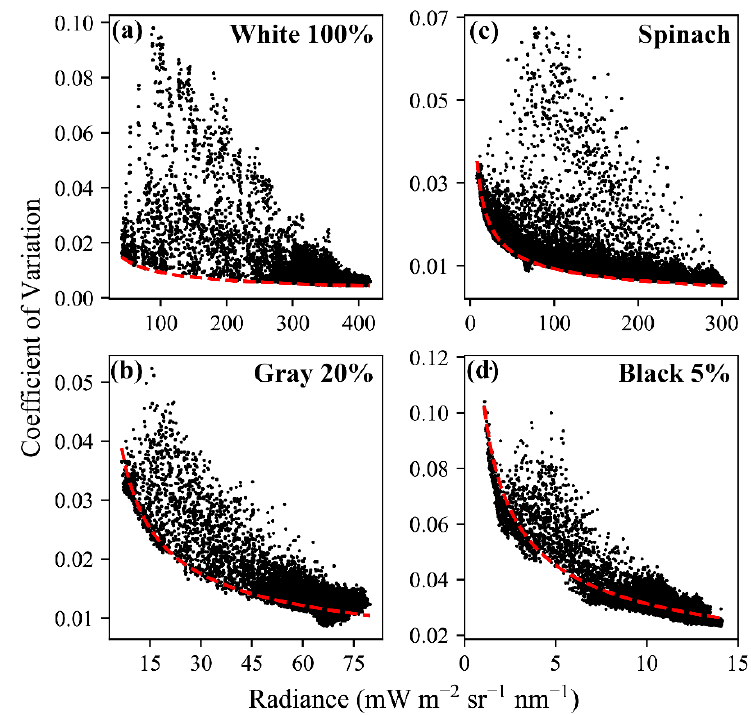
Figure 11. The coefficient of variation of FIREFLY radiance in spatial pixel 133, all bands, over thousands of consecutive samples (black dots) of four targets; white (a), gray (b), spinach (c) and black (d); compared to the expected coefficient of variation based on the noise characterization with the integrating sphere and ASD (red dashed line).